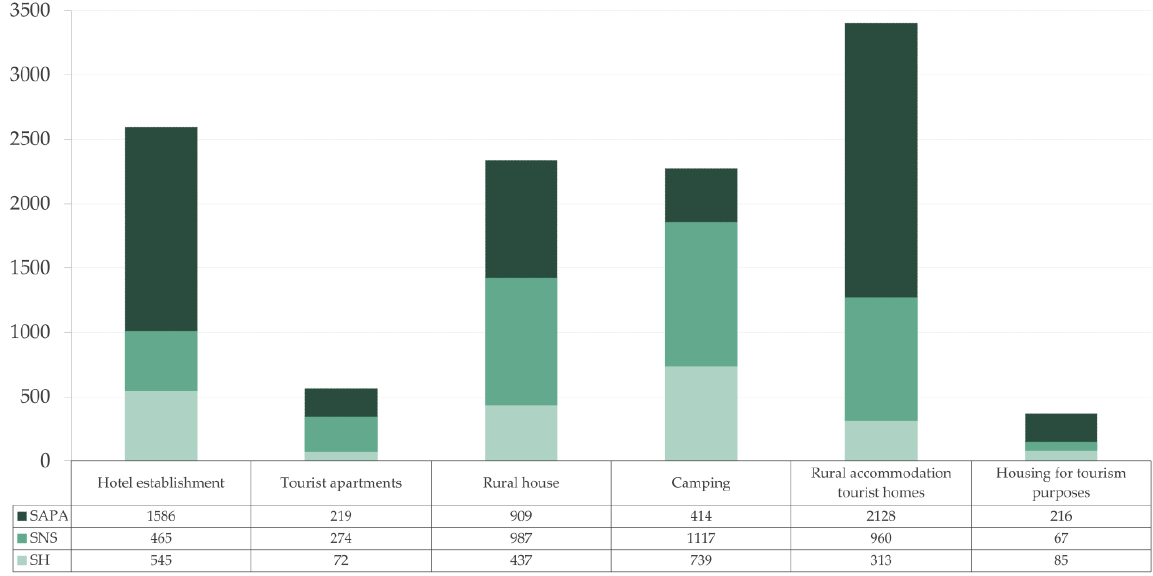
Figure 4. Evolution of the number of accommodation places. Data in red indicate estimations. Sources: [79,85]; authors’ elaboration.